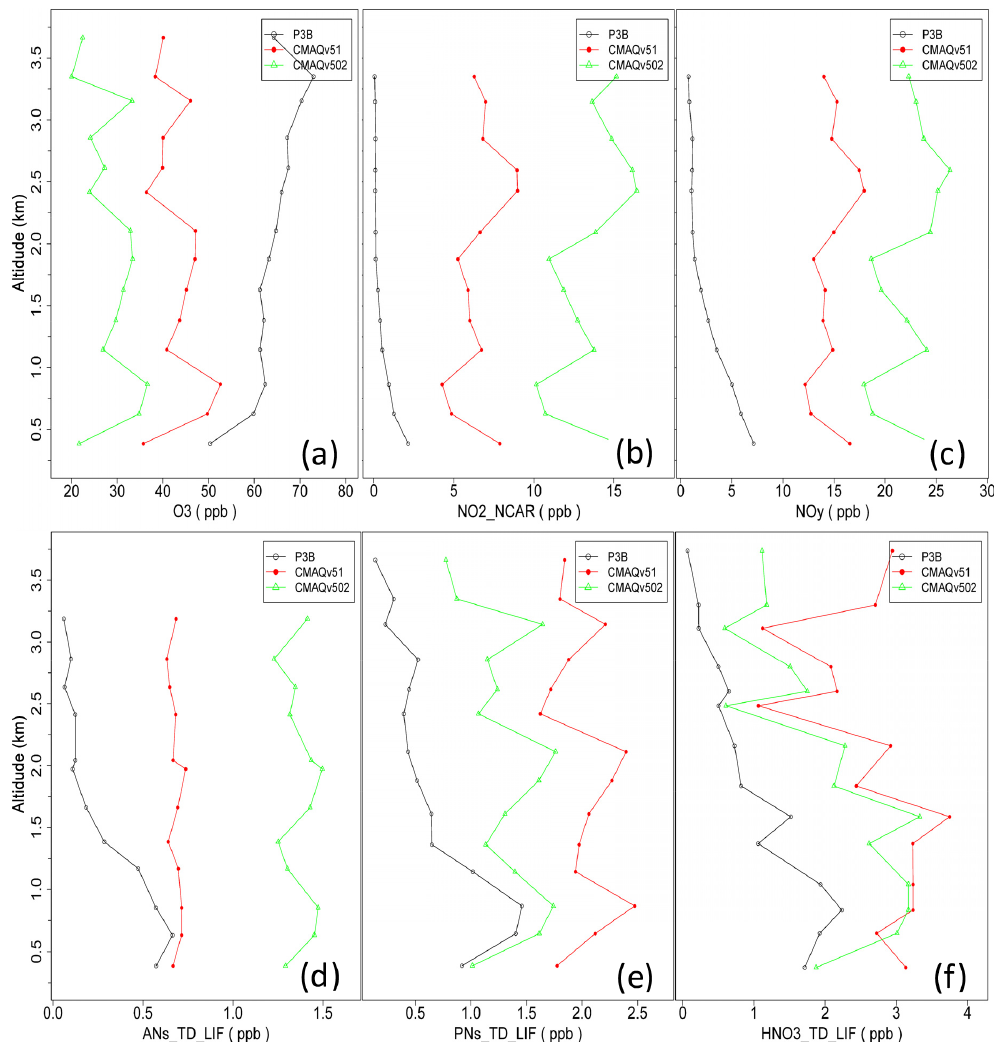
Figure 16. Observed (black) and CMAQ-simulated vertical profiles of (a) O 3 , (b) NO 2 , (c) NO y , (d) alkyl nitrates (ANs), (e) peroxy nitrates (PNs) and (f) HNO 3 for the Edgewood site in Baltimore, MD, on 5 July 2011. CMAQv502_Base simulation profiles are shown in green and CMAQv51_Base_NEIv1 simulation profiles are shown in red. Altitude (km) is given on the y axis, while mixing ratio (ppbv) is given on the x